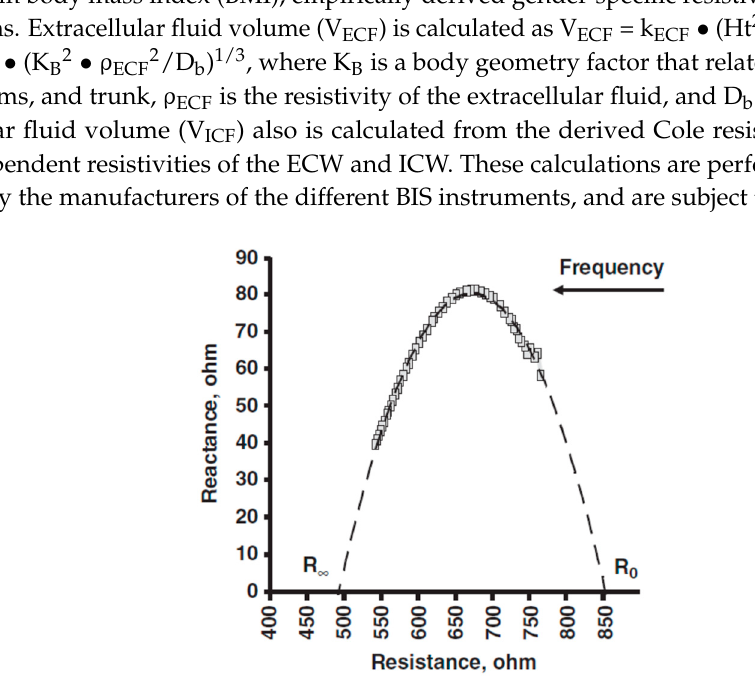
Figure 4. Plot of reactance and resistance of a healthy male obtained with a Xitron 4200 and derived using non-linear curve-fitting software based on the Cole model. Note that the majority of values (dashed lines) were estimated. R 0 and R ∞ were calculated and they approximate resistance at 0 and the highest frequency, respectively.